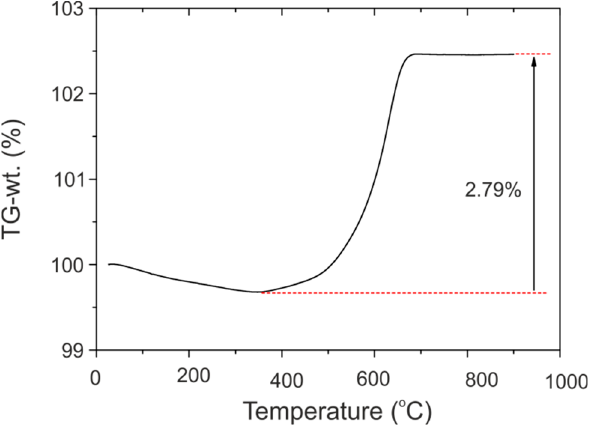
Figure 2. TG trace for BTOH upon heating under a dry air stream. Table 1. Characterization summary for BTOH.